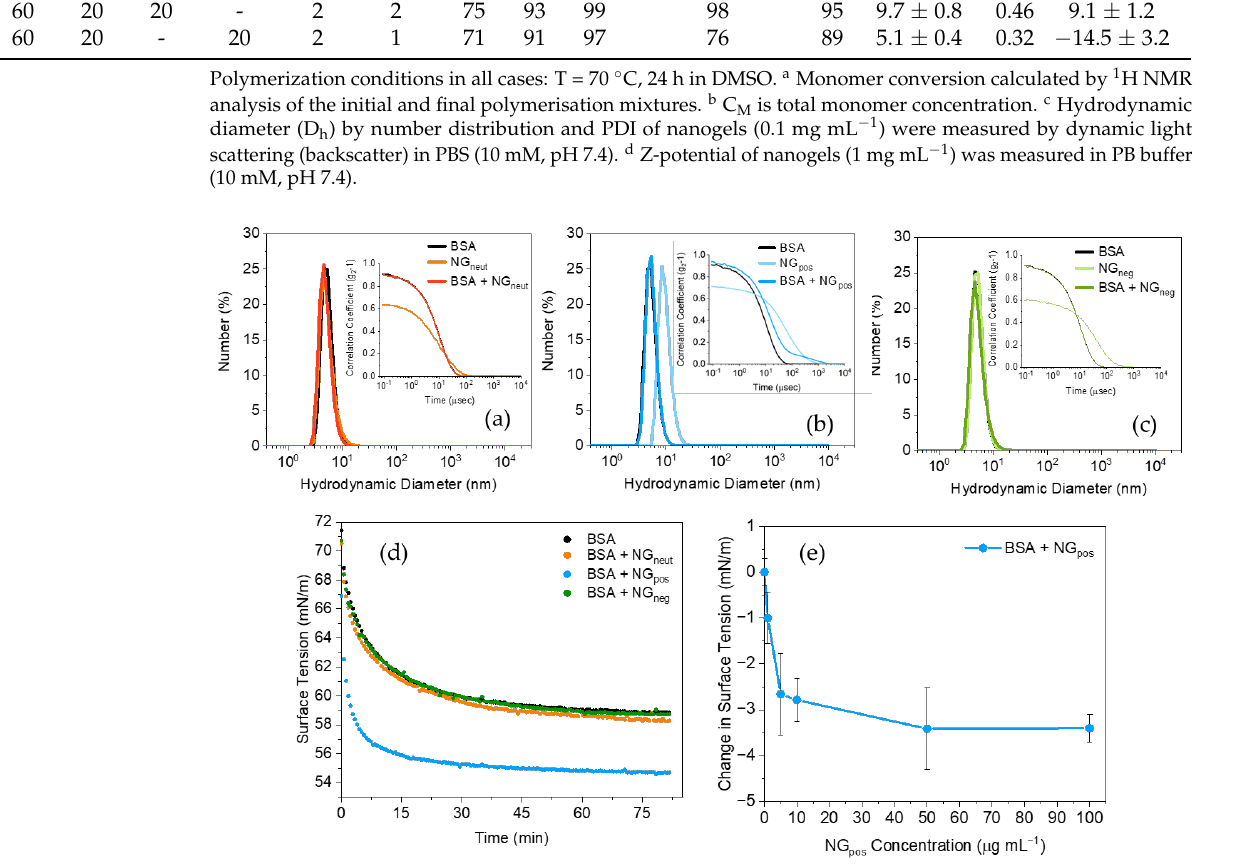
Figure 1. Interaction study of ( a ) neutral (NG neut ), ( b ) positively (NG pos ), and ( c ) negatively (NG neg ) charged nanogels with 35 mg mL − 1 BSA (black) by DLS (number distribution). ( d ) Dynamic surface tensiometry of NG neut (orange), NG pos (blue), and NG neg (green) in presence of 100 μ g mL −1 BSA compared to the pure protein (black). ( e ) Equilibrium surface tension values for BSA (100 μ g mL −1 ) with increasing concentration of NG pos (0 – 100 μ g mL −1 ). All measurements were conducted in PBS (10 mM, pH = 7.4) at 25 °C.